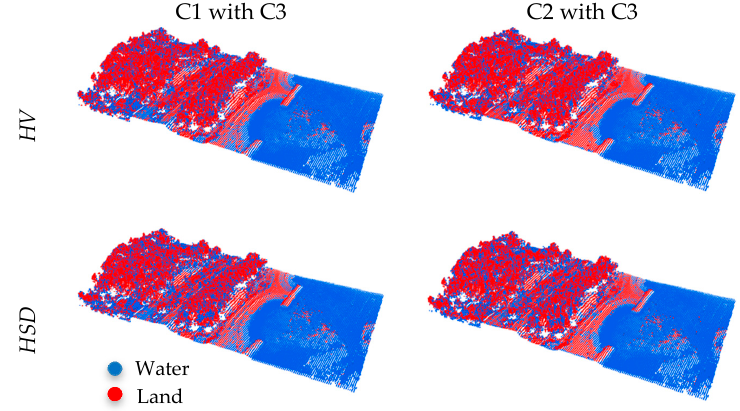
Figure 5. Labeled LiDAR points based on HV and HSD . Table 4. Accuracy measures of labeled point based on HV and HSD . The best results are highlighted in bold.